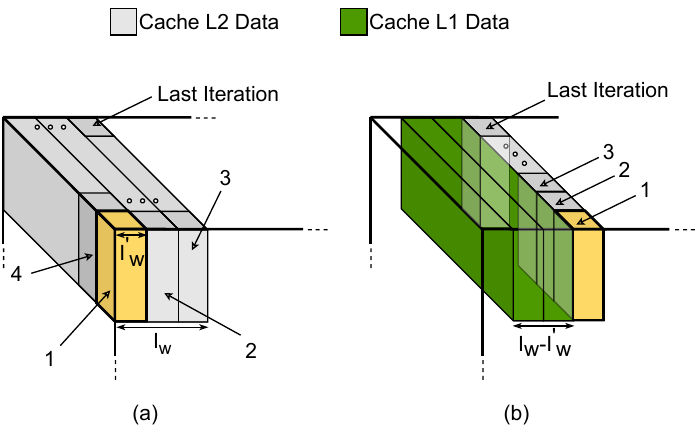
Figure 3. Scheduling operations and Cache L2-L1 behavior for filter size f = 3 × 3 with horizontal stride S w = 1. The numbers indicate the position of the yellow box at consecutive clock cycles.